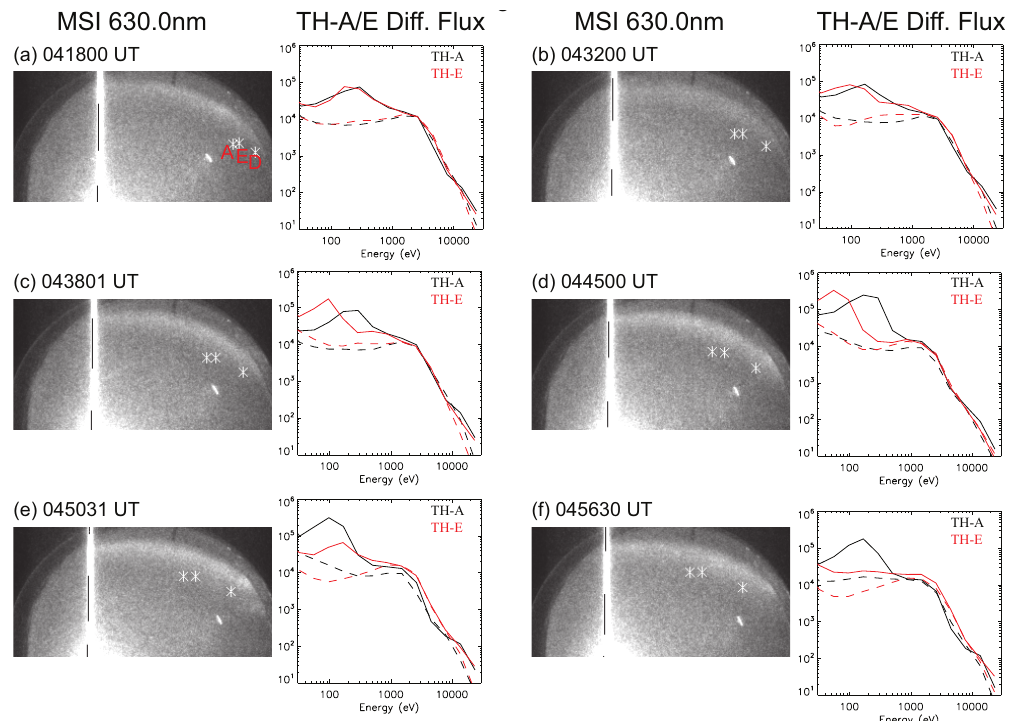
Fig. 11. A few selected images from GILL MSI 630.0nm observations. In each image the up-direction denotes the geographical north and the right-direction denotes the geographical east. The footprints of TH-A/D/E, calculated from T02 model by assuming a 230km mapping height, are plotted as asterisk for reference. To the right of each image is the corresponding electron number flux spectra, including the TH-A parallel spectrum (black solid curve), TH-A perpendicular spectrum (black dashed curve), TH-E antiparallel spectrum (red solid curve), TH-A perpendicular spectrum (red dashed